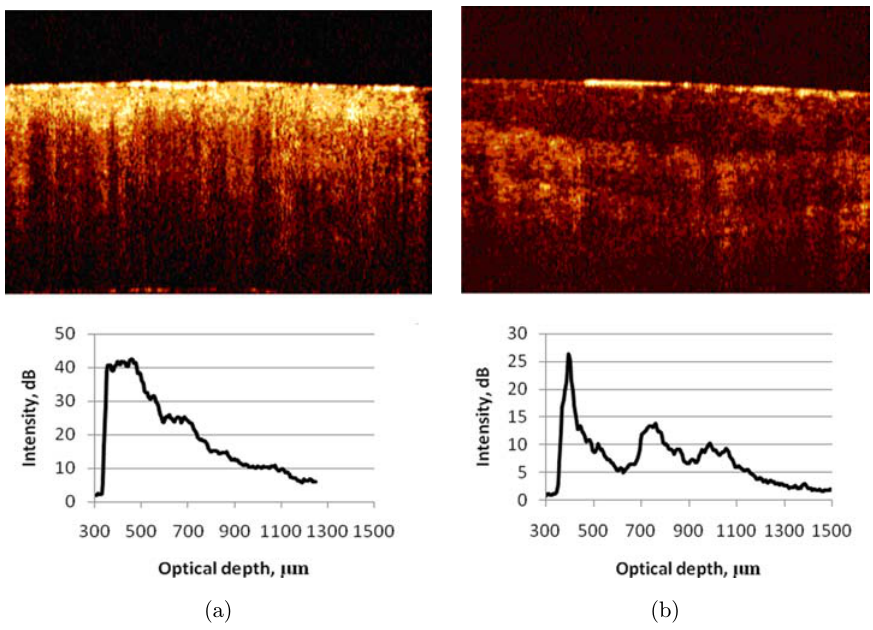
Fig. 2. OCT images and A-scans of thick palm skin of a newborn (a) and a teenager